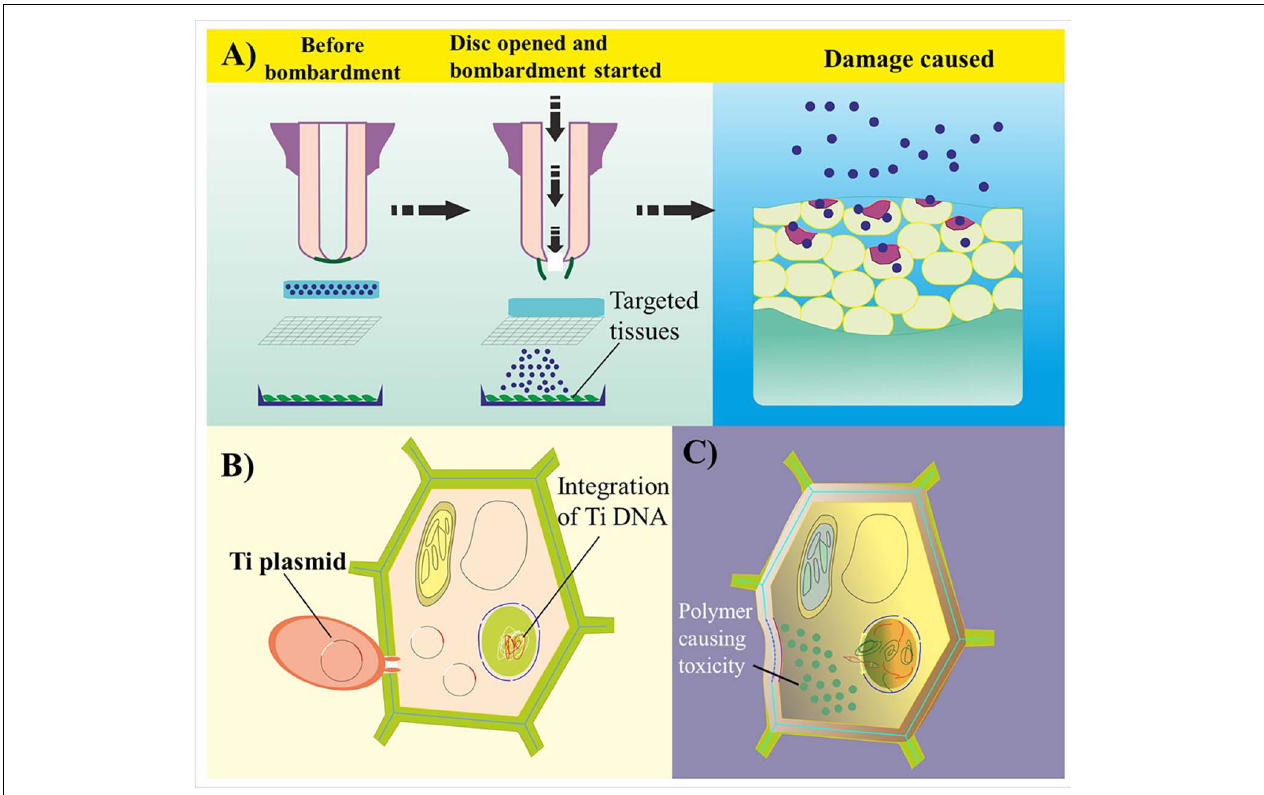
FIGURE 4 | Common challenges in genome editing- and nanoparticle-mediated plant transformation. (A) Biolistic delivery of biomolecule-coated particles into targeted plant cell tissues. Because of the unavoidable high velocity of genetic cargo, the bombarded particles damage the cell wall through penetration and disrupt cell homeostasis. (B) Transformation of plant cells via Agrobacterium -mediated transformation. The T-DNA of Agrobacterium integrates within the host genome, causing a tumor or a change in the genetic information of the transformed cells. (C) Polymer-based transformation leads to cytotoxicity in plant cells because of the accumulation of high-density charged polymer-based genetic cargo. A reduction in charge leads to an impairment in the bioconjugated